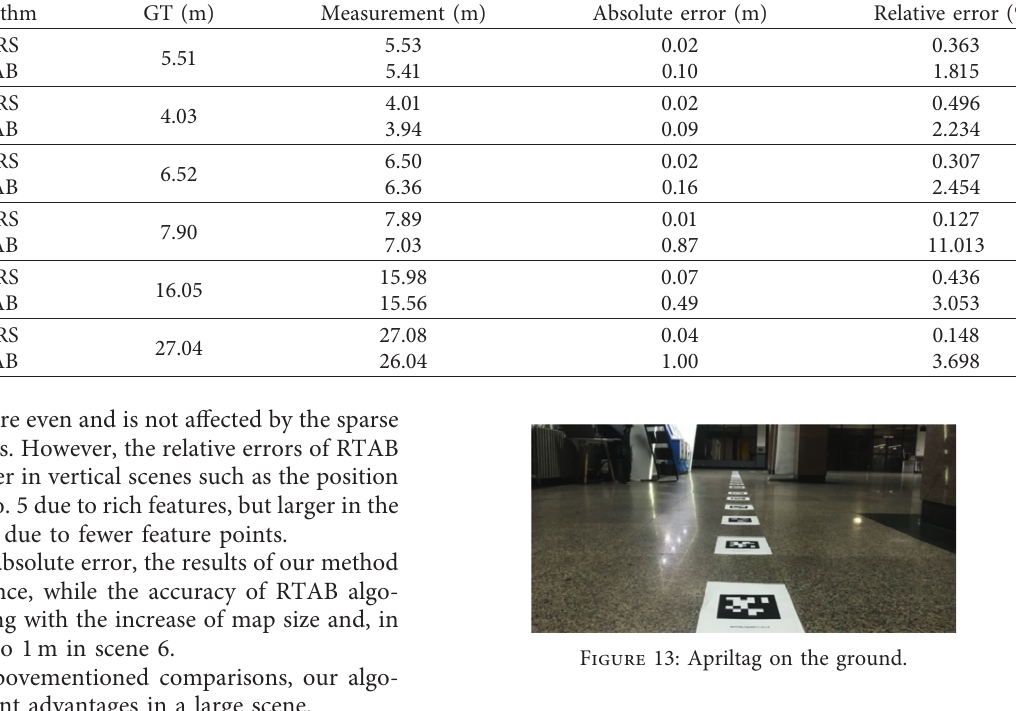
Table 2: Measurement results of 3D mapping